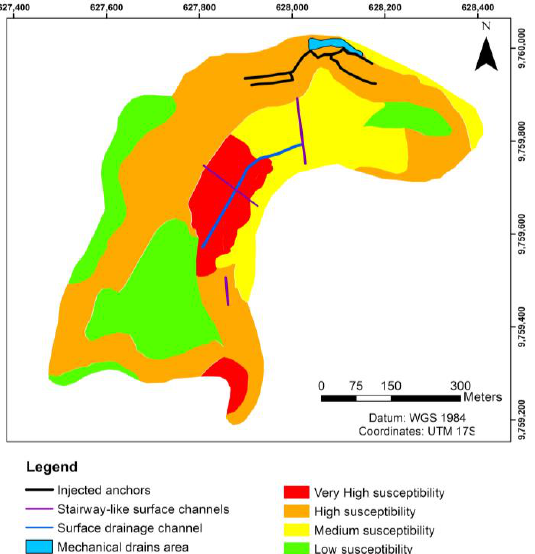
Figure 12. Recommended stabilization solutions by location in the study area.